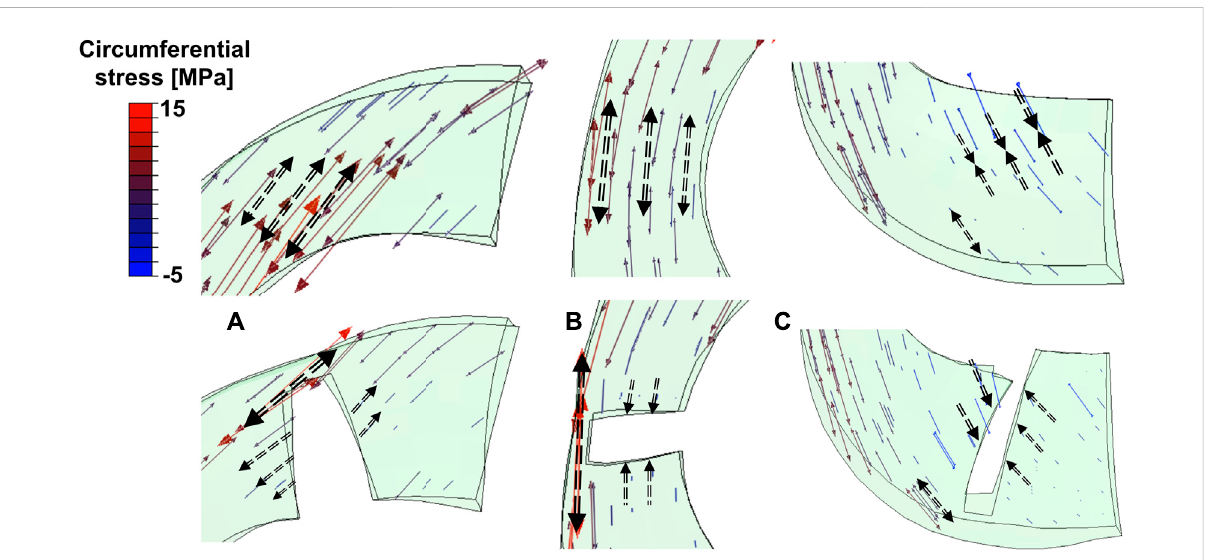
FIGURE 7 Tensorplotsofcircumferentialstressforthe (A) anteriorhorn, (B) midbody,and (C) posteriorhornwith83%widthtears.Thecolorchangesfrom blueto redrepresent thestress variation from small (negative, compressive stress)to large (positive, tensile stress) on thetensorplot. Dashed arrows indicated circumferential stress in tensile or compressive directions. Thicker longer arrows represent higher